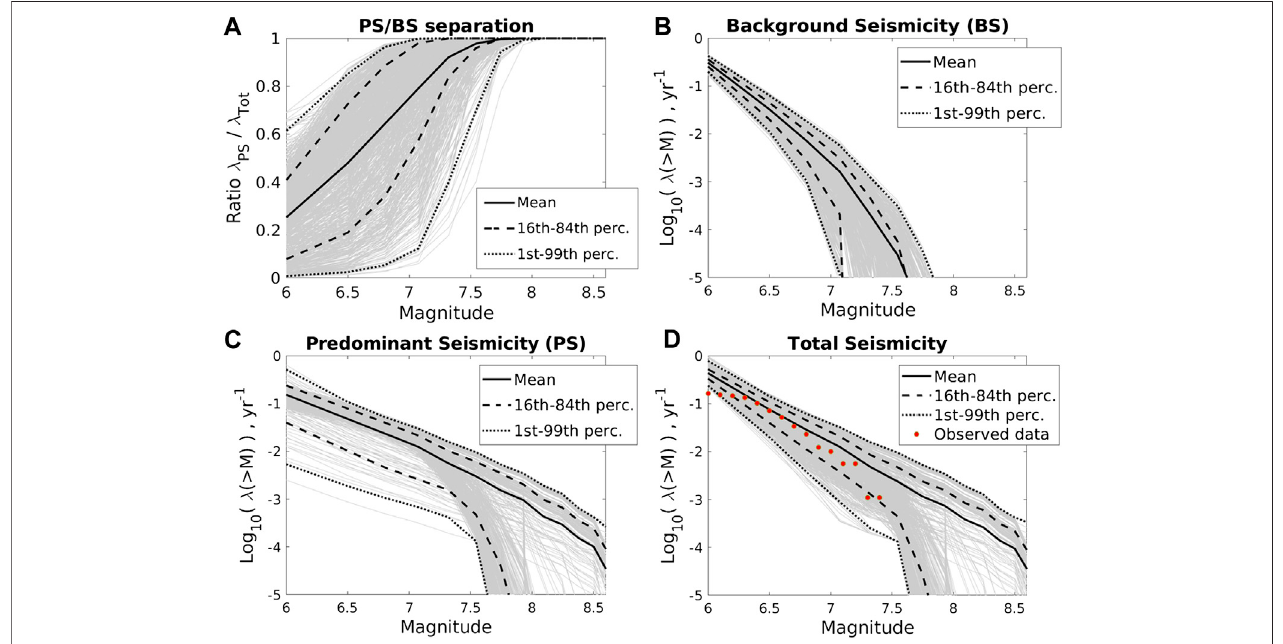
FIGURE 7 | Example of frequency-magnitude distributions for the Kefalonia-Lefkada, Greece, region. (A) Ratio between seismicity assigned to the PS type and total seismicity, evaluated with the Bayesian separation model. (B) BS seismicity type computed for all the alternative models (1,000 samples) and statistics of the epistemicuncertainty. (C) Sameaspanel (B) ,butforPSseismicity. (D) Totalseismicity,obtainedbysummingtheBSandPScontributions,comparedwiththeobserved data from the relevant seismicity catalog. Grey lines in all panels represent the distribution samples.